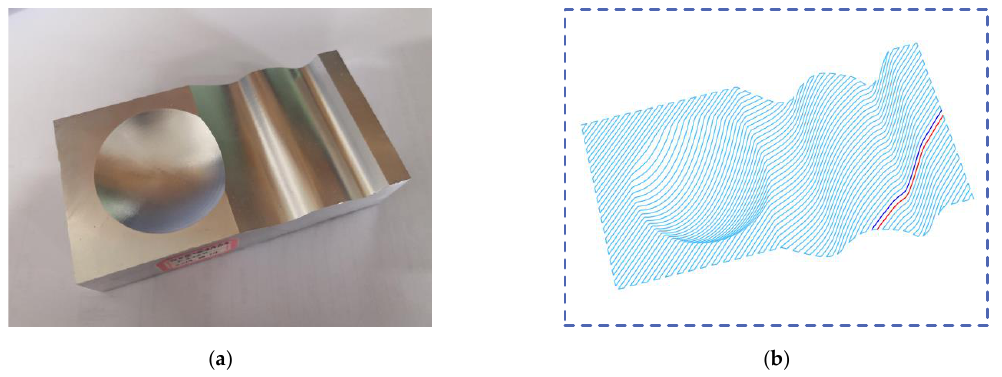
Figure 8. The workpiece and its machining path: ( a ) the workpiece; ( b ) the machining path (simplified).